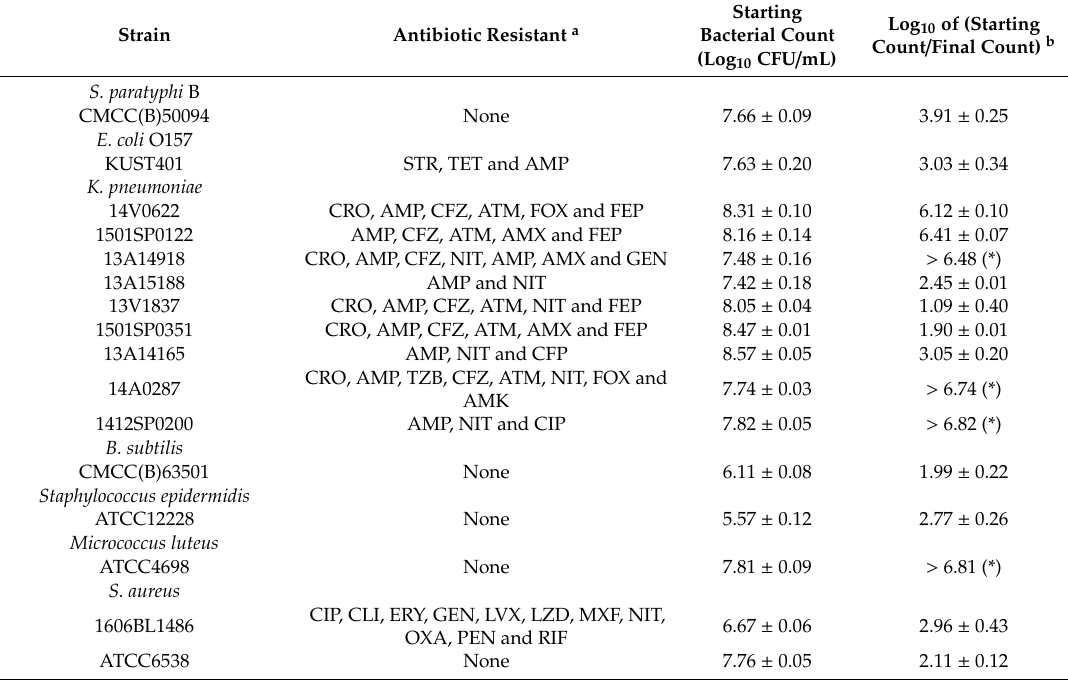
Table 1. Bactericidal activity of TSPphg against various strains of Gram-negative or Gram-positive bacteria. Strain Antibiotic Resistant a